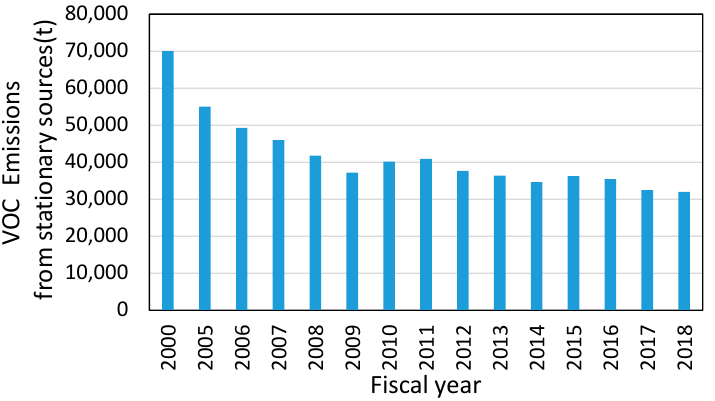
Figure 22. Trend in volatile organic compound (VOC) emissions from stationary sources in Kanagawa Prefecture (estimated based on the VOC inventory report from the MOE).